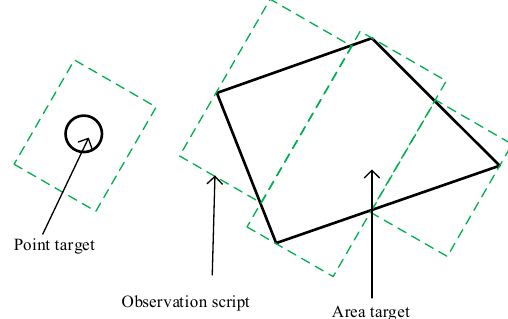
Figure 2. Illustration of the point target and area